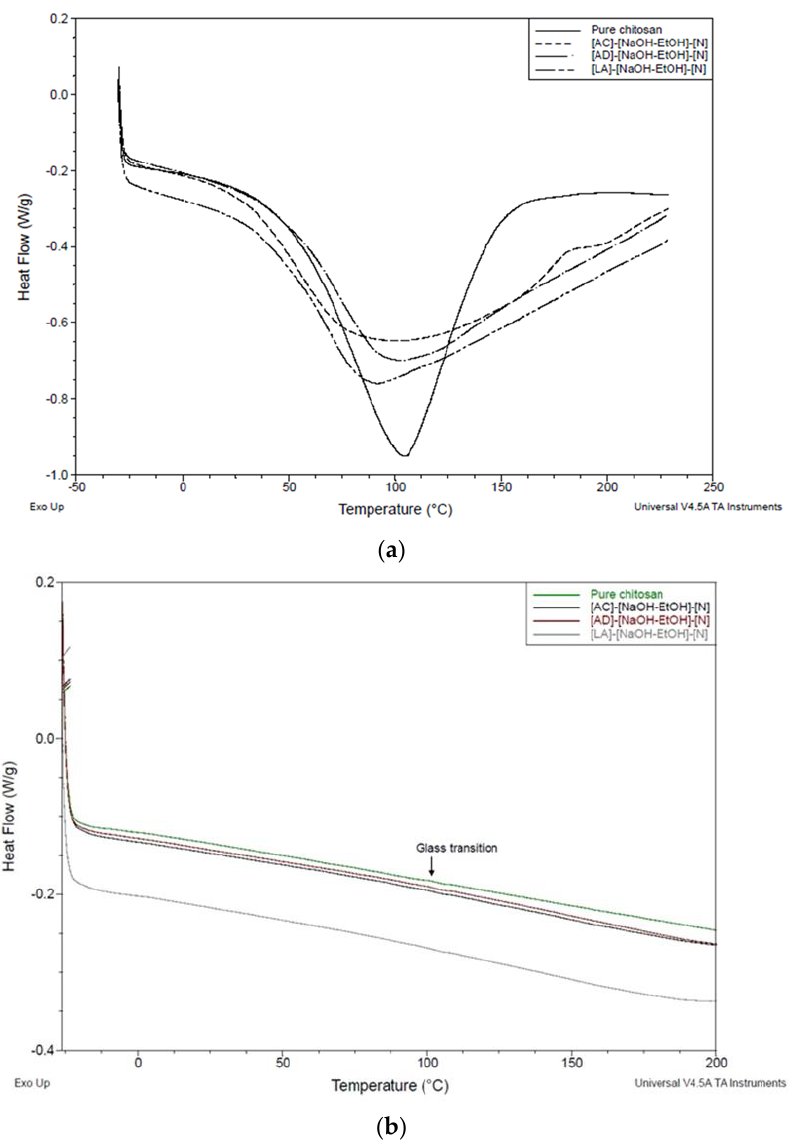
Figure 5. DSC traces of chitosan fibers and pure chitosan: ( a ) first heating run and ( b ) second heating run.